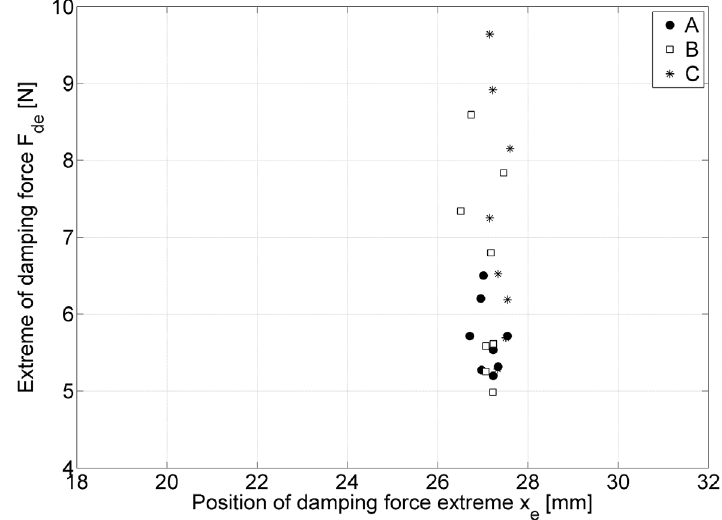
Fig. 4. Positions and values of damping force extreme.